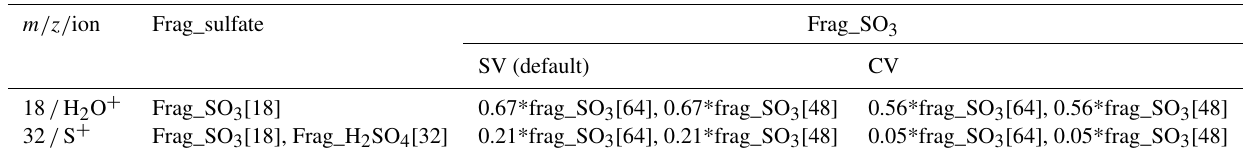
/ NO + for NH 4 NO 3 and (b) SO + x / SO + for (NH 4 ) 2 SO 4 measured with AMS with the SV and CV. Figure 3. Scatter plots of (a) NO + 2 / NO + ratios the NIST database for 70eV EI ionization of HNO 3 ( g ) , NO 2 ( g ) and NO(g) are also shown in (a) . SO + NO + 2 from NIST for SO 2 ( g ) and H 2 SO 4 ( g ) are also shown in (b) . SO + x ions include SO + Table 2. Changes of the fragmentation table for the AMS data analysis software, modified for the CV based on (NH 4 ) 2 SO 4 measurement in pure argon gas. The default settings in the analysis software for SV are also shown. These ratios should be implemented in both UMR and HR fragmentation